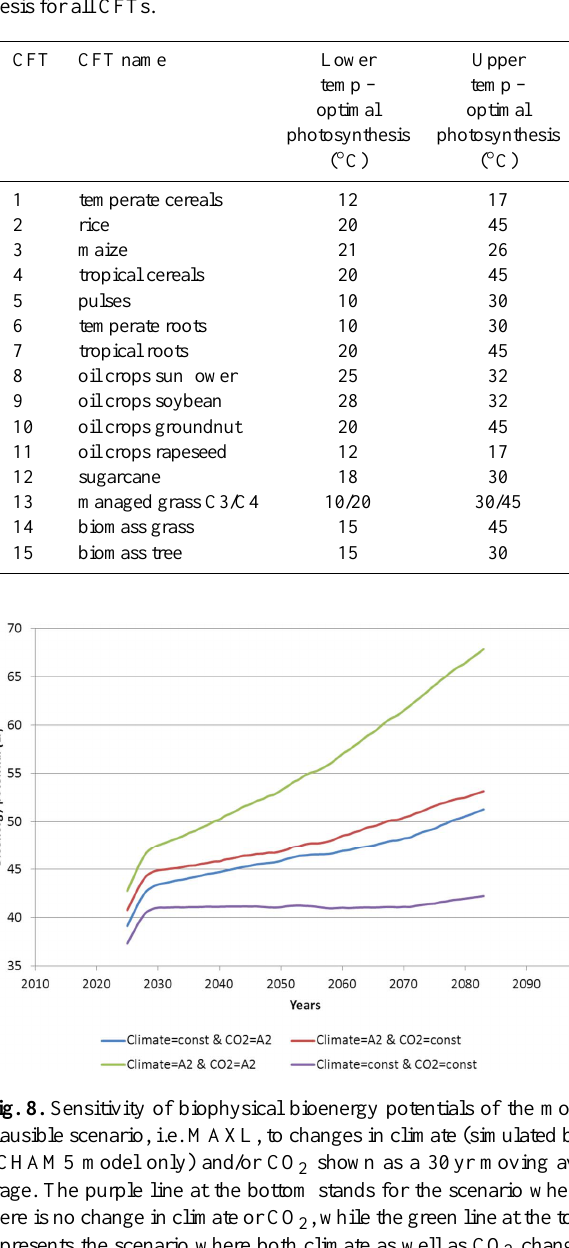
Table 3. Lower and upper temperature limits for optimal photosyn- thesis for all CFTs.